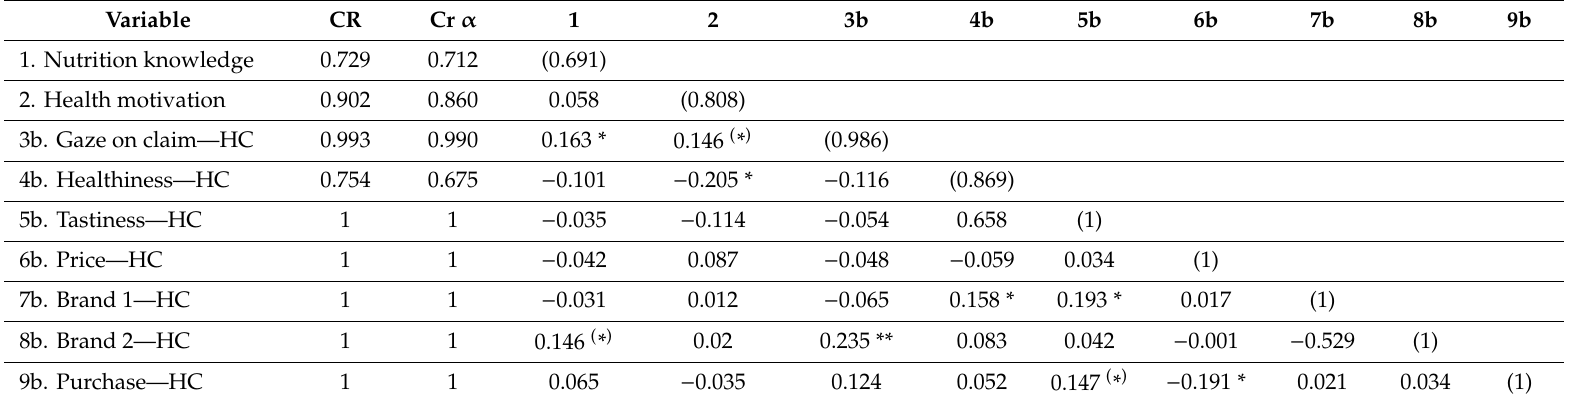
Table 6. Correlations, composite reliabilities, Cronbach α , and average variances extracted—health claim.